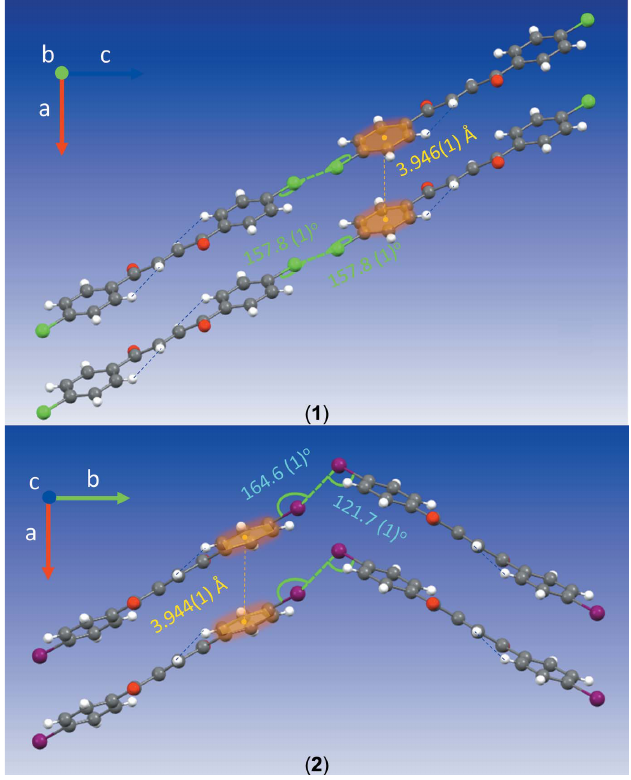
Figure 4 Molecular conformations of ( 1 ) and ( 2 ) viewed along the b and c axes, respectively, showing type I and II halogen interactions, centroid-to- centroid distances, and short intramolecular H (cid:3)(cid:3)(cid:3) H interactions.